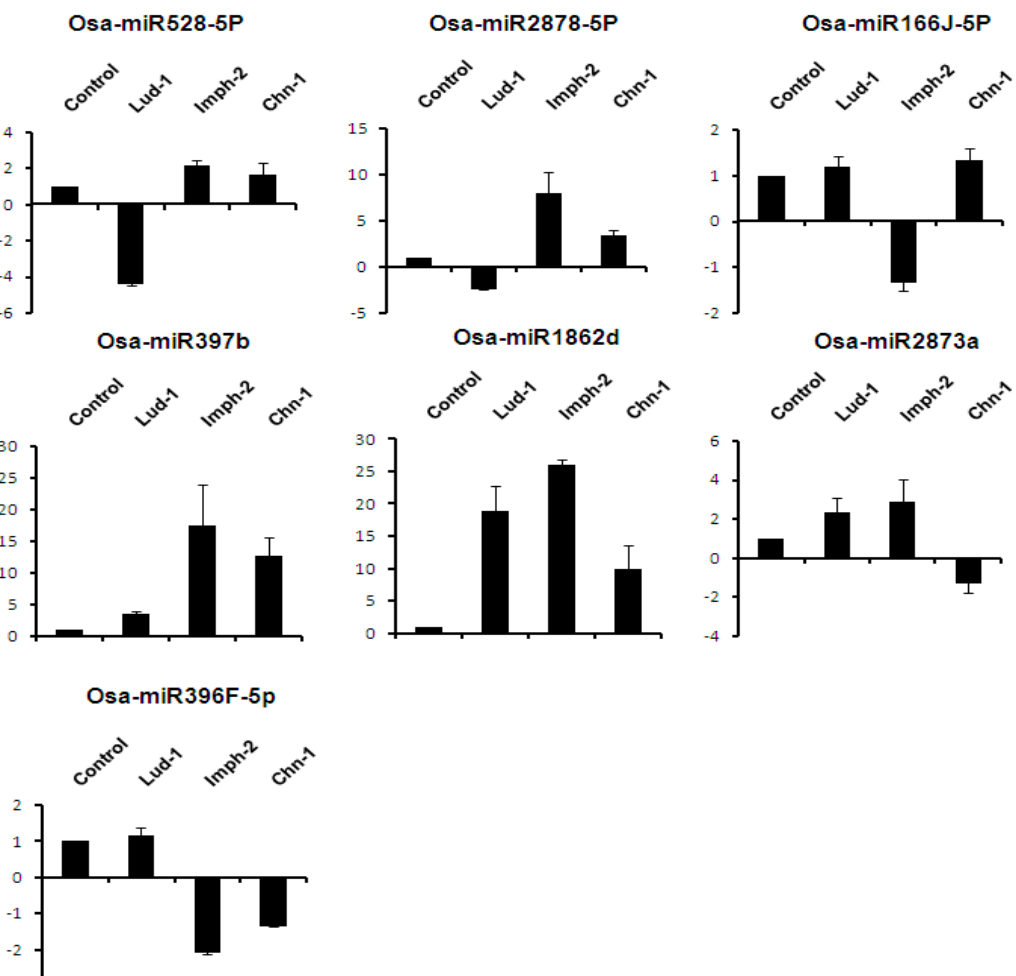
Figure 6. RT-qPCR expression analysis of miRNAs in the TN1 genotype inoculated with different strains of R. solani. Data is represented after internal reference gene U6 normalization. The error bars represent the standard error of three biological replicates. X -axis: samples and Y -axis: relative expression of miRNAs.